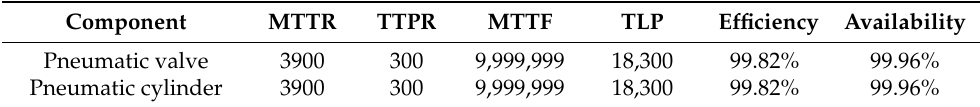
Table 13. Pneumatic component times in seconds. Efficiency and availability calculated in % with the IPPM